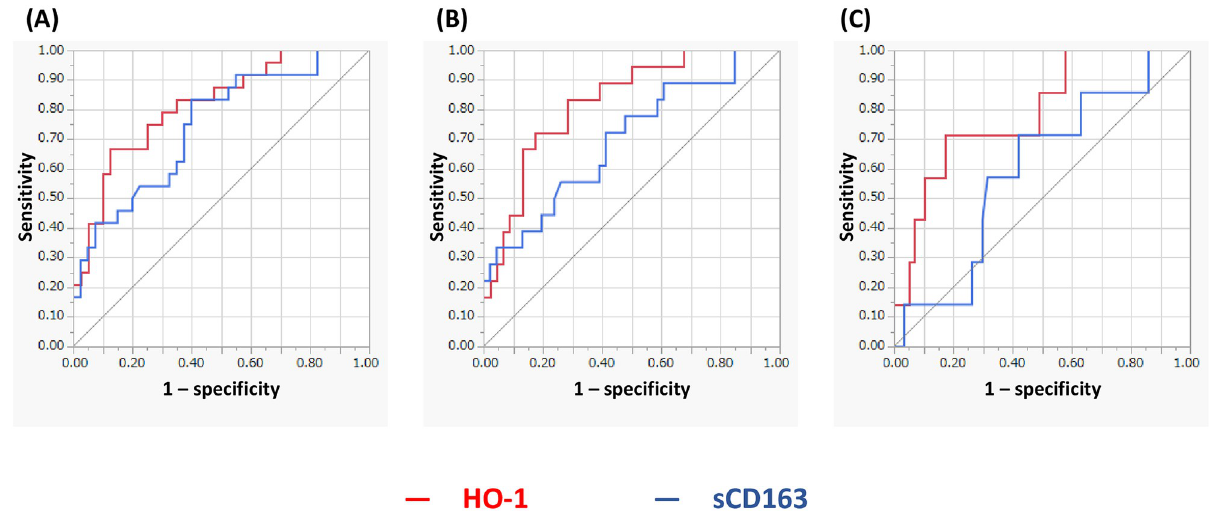
Fig 2. Prediction of intensive care unit (ICU) admission (A), mechanical ventilation support (B), and extracorporeal membrane oxygenation (ECMO) support (C) using serum heme oxygenase (HO)-1 (red line) and soluble CD163 (sCD163) levels (blue line). The receiver operating characteristic (ROC) curve analyses for serum HO-1 and sCD163 levels to predict treatment outcomes including ICU admission and mechanical ventilation or ECMO support. The area under the ROC curve (AUC) for predicting ICU admission was 0.816 for serum HO-1 and 0.743 for sCD163 (A). The AUC for predicting mechanical ventilation support is 0.827 for serum HO-1 and 0.696 for sCD163 (B). The AUCs for predicting ECMO support are 0.790 and 0.598, respectively (C).